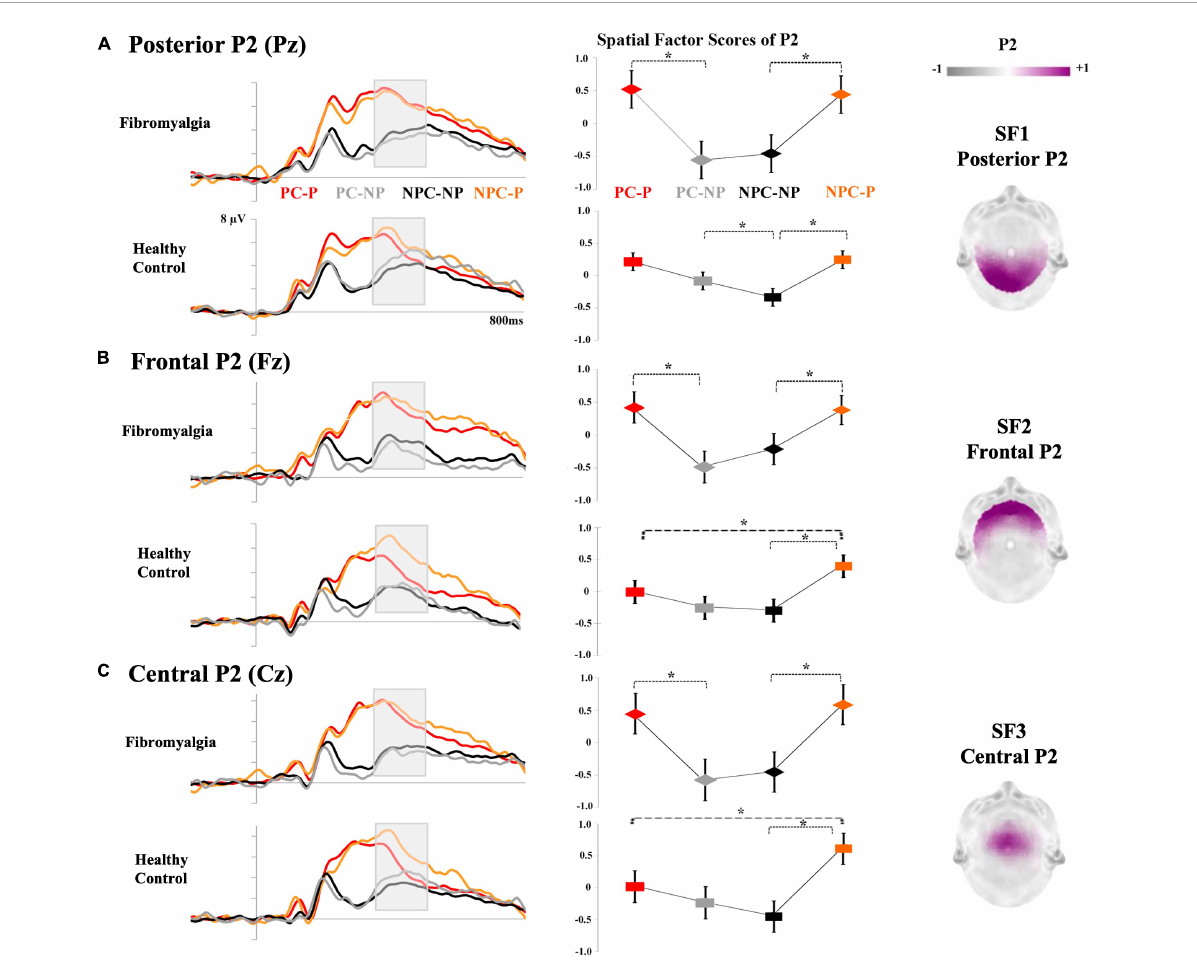
FIGURE5 Grand averages of LEP components (pain-processing period): The left side of the figure represents the P2 waveform for fibromyalgia and healthy control groups in response to PC-P (red), NPC-P (orange), PC-NP (gray) and NPC-NP (black) conditions. The means of the P2 spatial factor scores for each experimental condition are displayed in the middle. Asterisks represent significant differences (* p < 0.05). Bars indicate the standard error. The topographical maps of each scalp region of P2 are shown on the right side. (A) Pz for posterior P2, (B) Fz for frontal P2, and (C) Cz for the central P2 scalp regions. (PC-P, pain cue - pain; NPC-P, no pain cue - pain; NPC-NP, no pain cue - no pain; PC-NP, pain cue - no